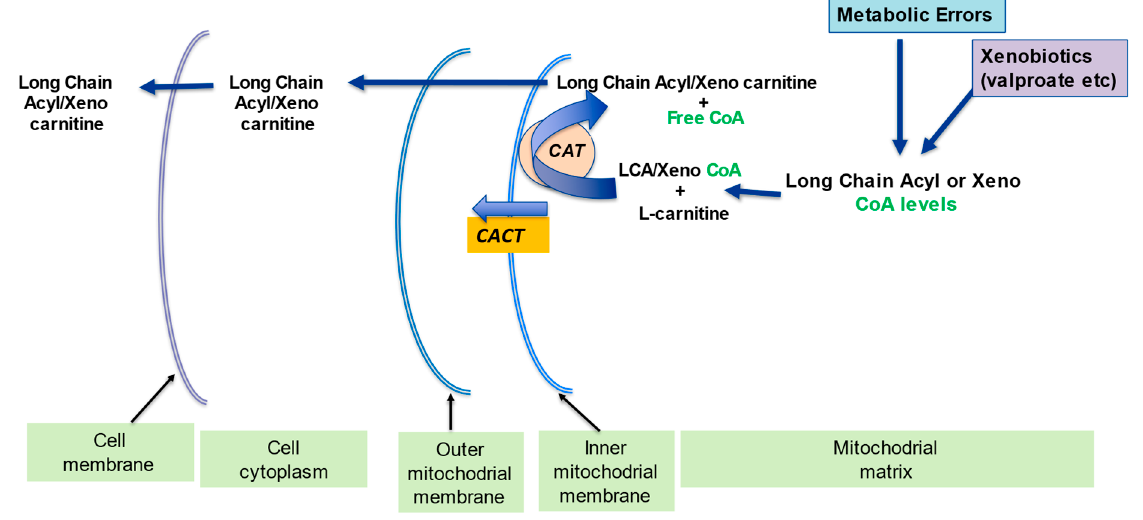
Figure 7. L-Carnitine needed for removal of long chain acyls and xenobiotics from mitochondria. Adapted from Virmani et al., 2015 [2]. The acetyl-CoA build-up of long chain acyl CoA and Xeno-CoA from metabolic errors and xenobiotics would reduce free mitochondrial CoA levels, as well as be detrimental by themselves. The L-carnitine coverts these long chain acyls-carnitine or Xeno-carnitine, which can be transported out of the mitochondrial matrix and the cell.